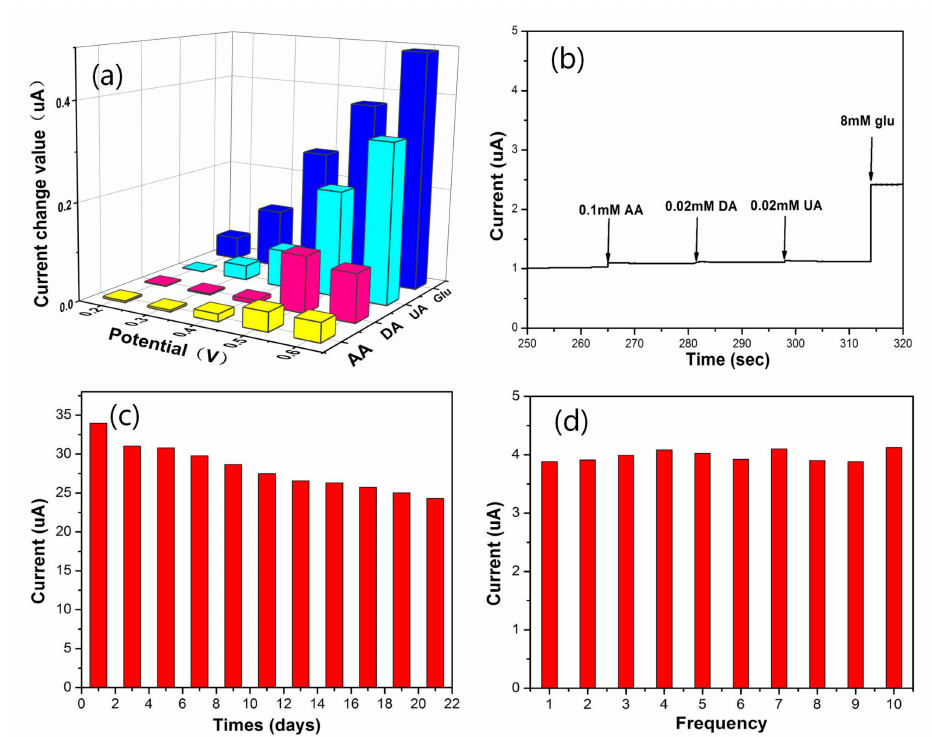
Figure 7. Current values of the Fc-CHIT / CNT@Cu electrode with the addition of ascorbic acid (AA), dopamine (DA), uric acid (UA) and glucose (0.1 M NaOH) ( a ) under di ff erent applied potentials; ( b ) under 0.44 V applied potential; ( c ) study of sensor stability over 7 days with addition of 4 mM glucose; ( d ) repeatability was measured by 10 successive measurements of the same sensor at 0.44 V potential, with addition of 4 mM